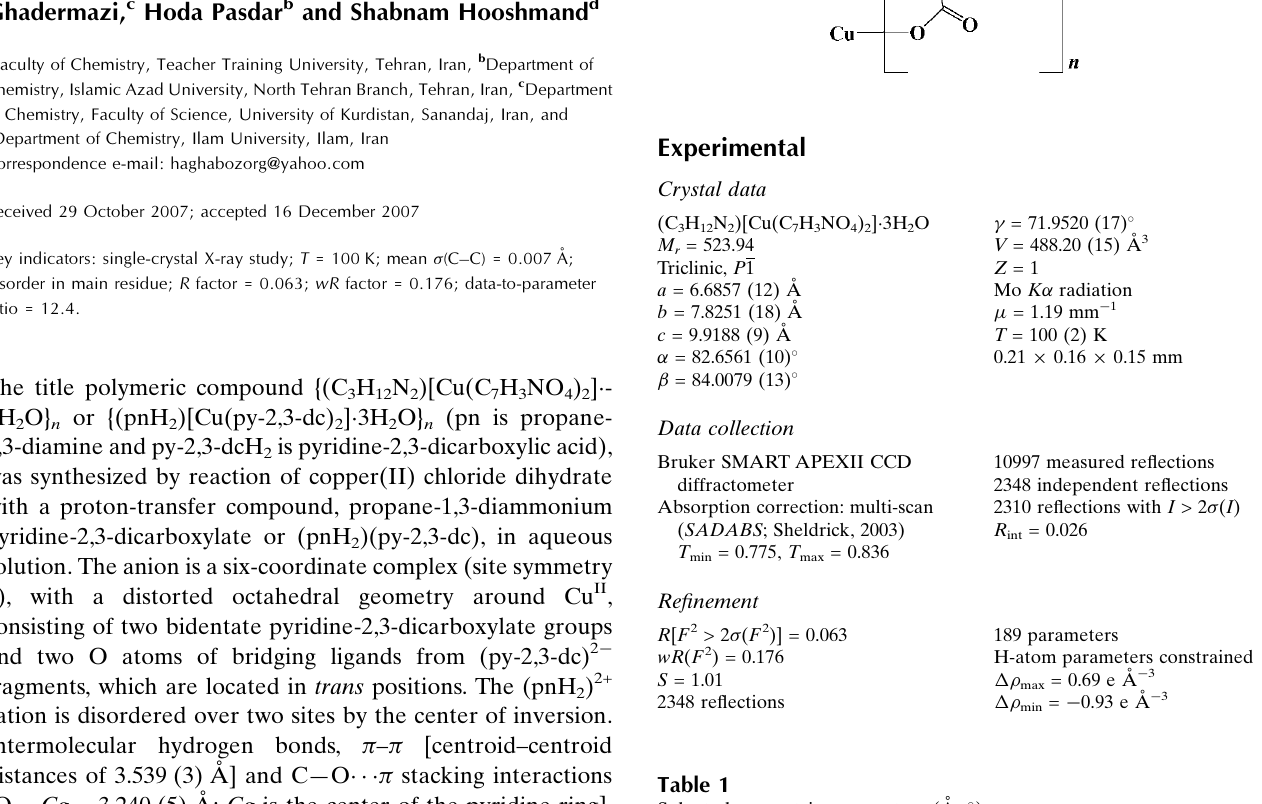
Selected geometric parameters (A˚ , (cid:3) ).